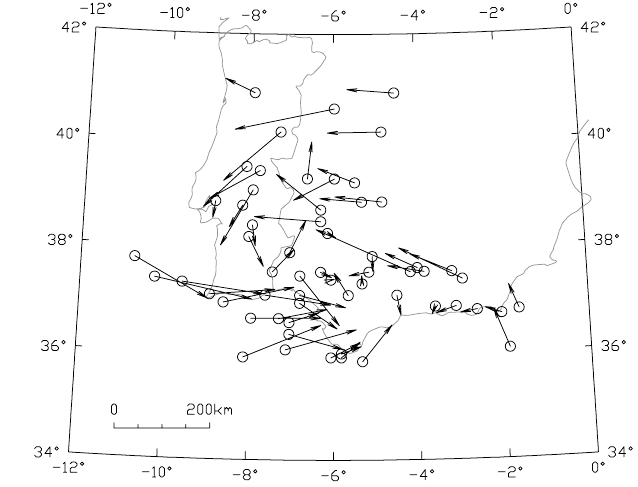
Figure 4. Hispania Baetica and Hispania Lusitania : residual plot after an adjustment of scale and shift ( point : ( ¯ λ, ¯ φ ), arrowhead : ( λ,φ )).